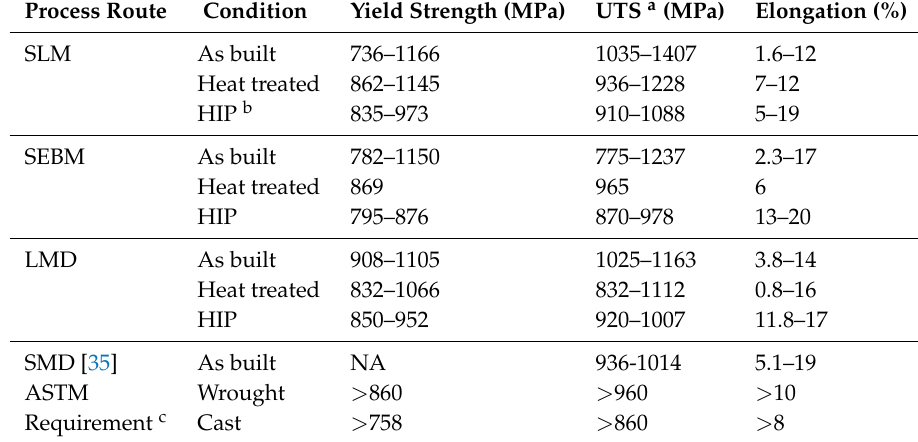
Table 1. A summary of reported mechanical properties of Ti-6Al-4V material manufactured using different AM process routes. Data taken from Lewandowski and Seifi [32] and Baufeld et al.